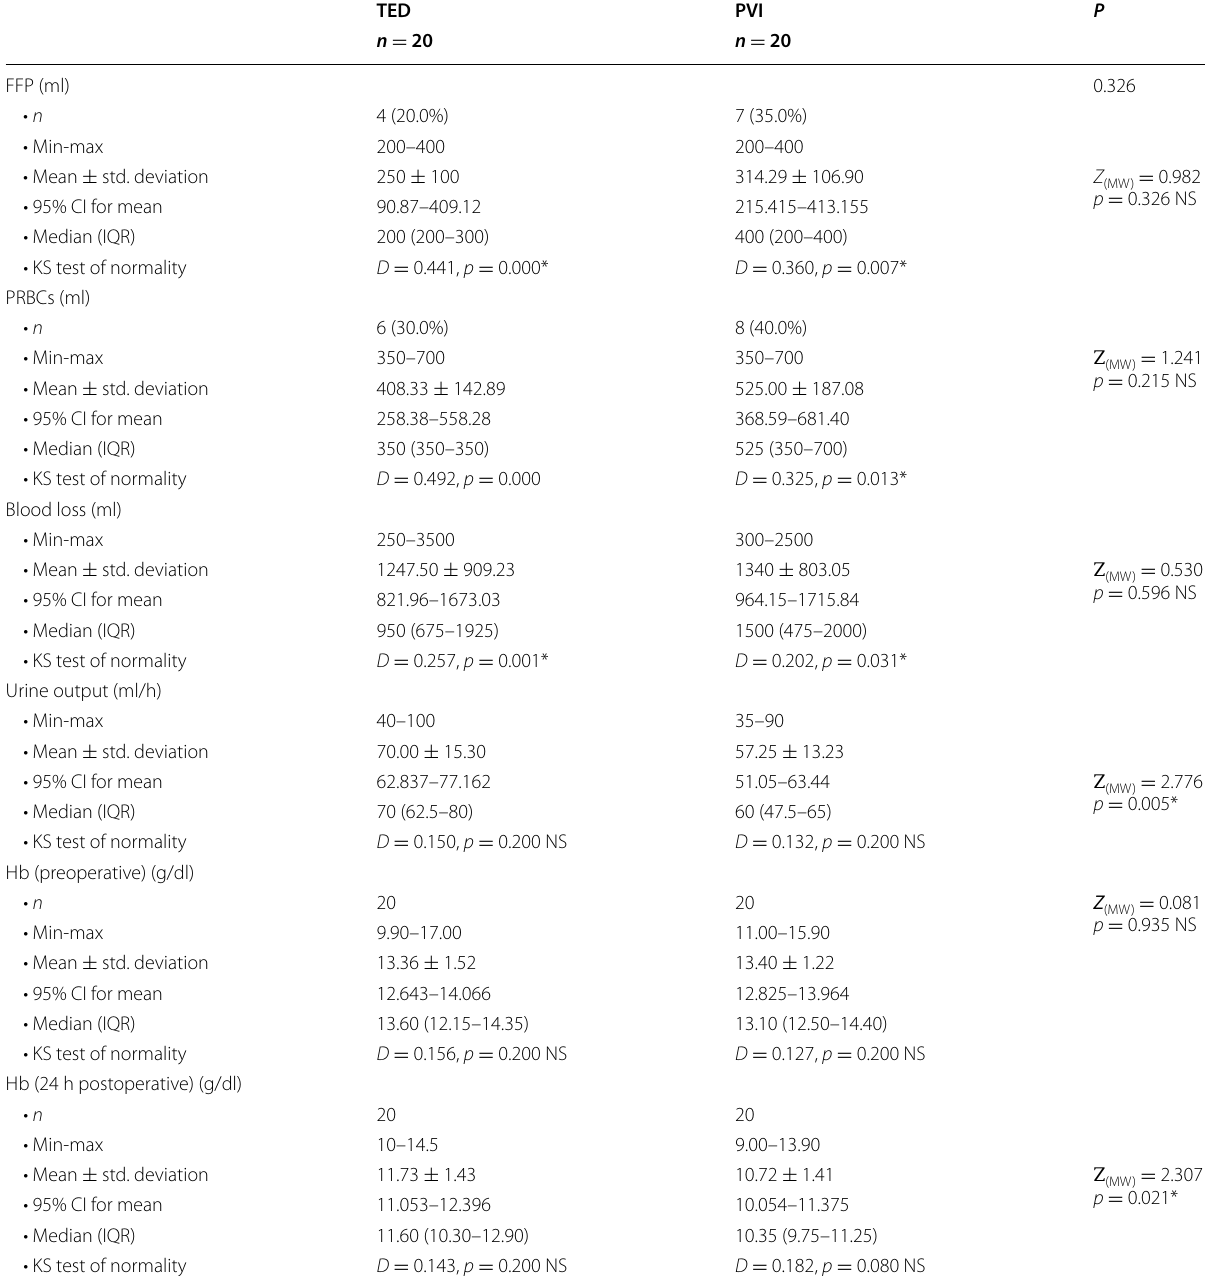
Table 4 Consumed packed red blood cells (PRBCs) and fresh frozen plasma (FFP) in milliliter respectively. PRBCs unit (350 ml), FFP